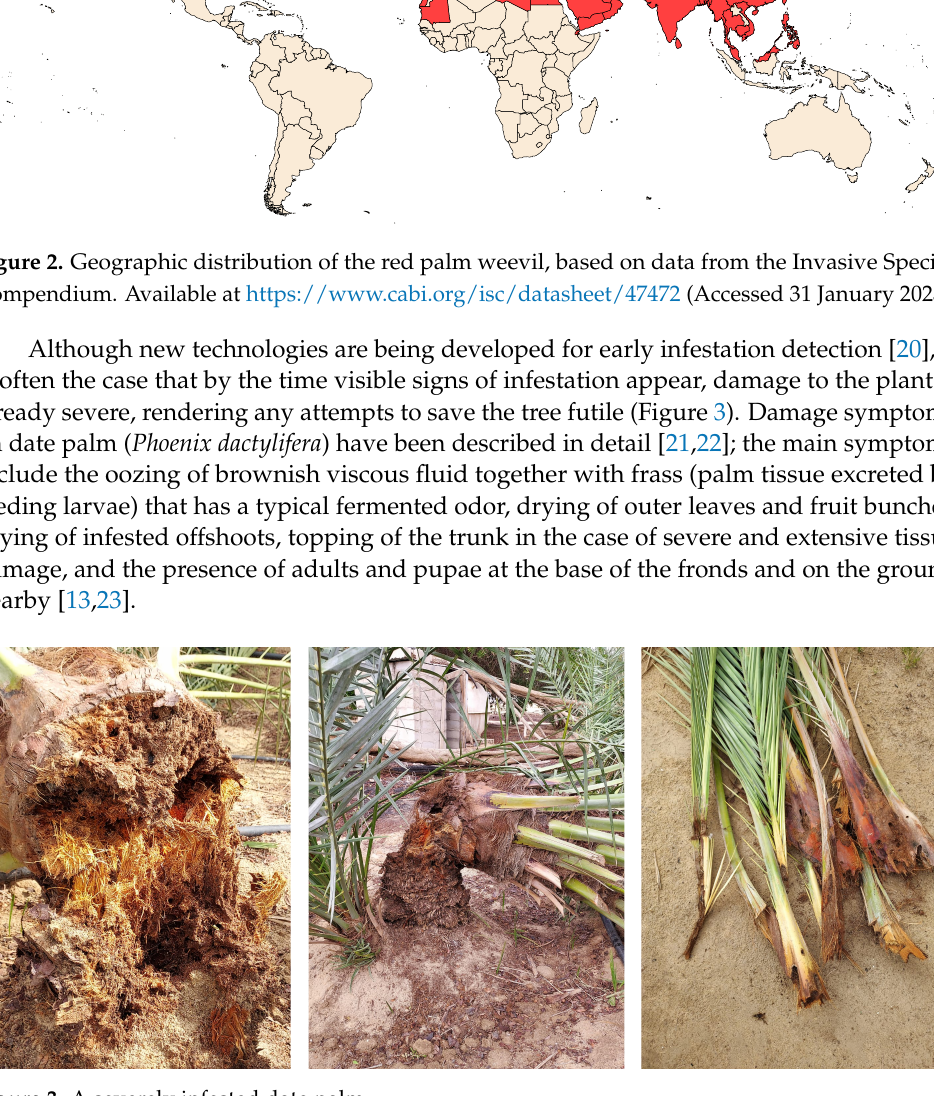
Figure 3. A severely infested date